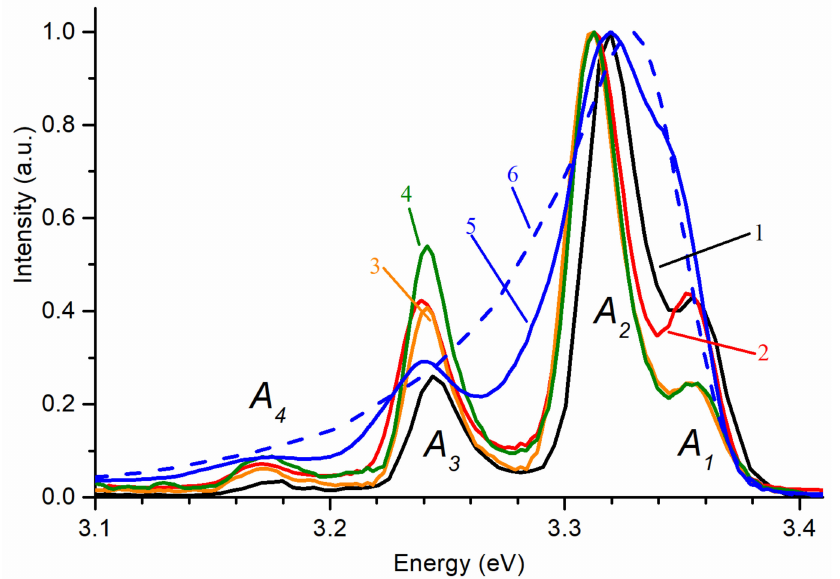
Figure 4. RL spectra at 80 K in the spectral range of NBE emission of ZnO samples: 1—whiskers; 2—air annealed whiskers; 3—nanowalls; 4—multipods; 5—undoped ceramics; 6—ZnO:Ga ceramics. Spectra are normalized at